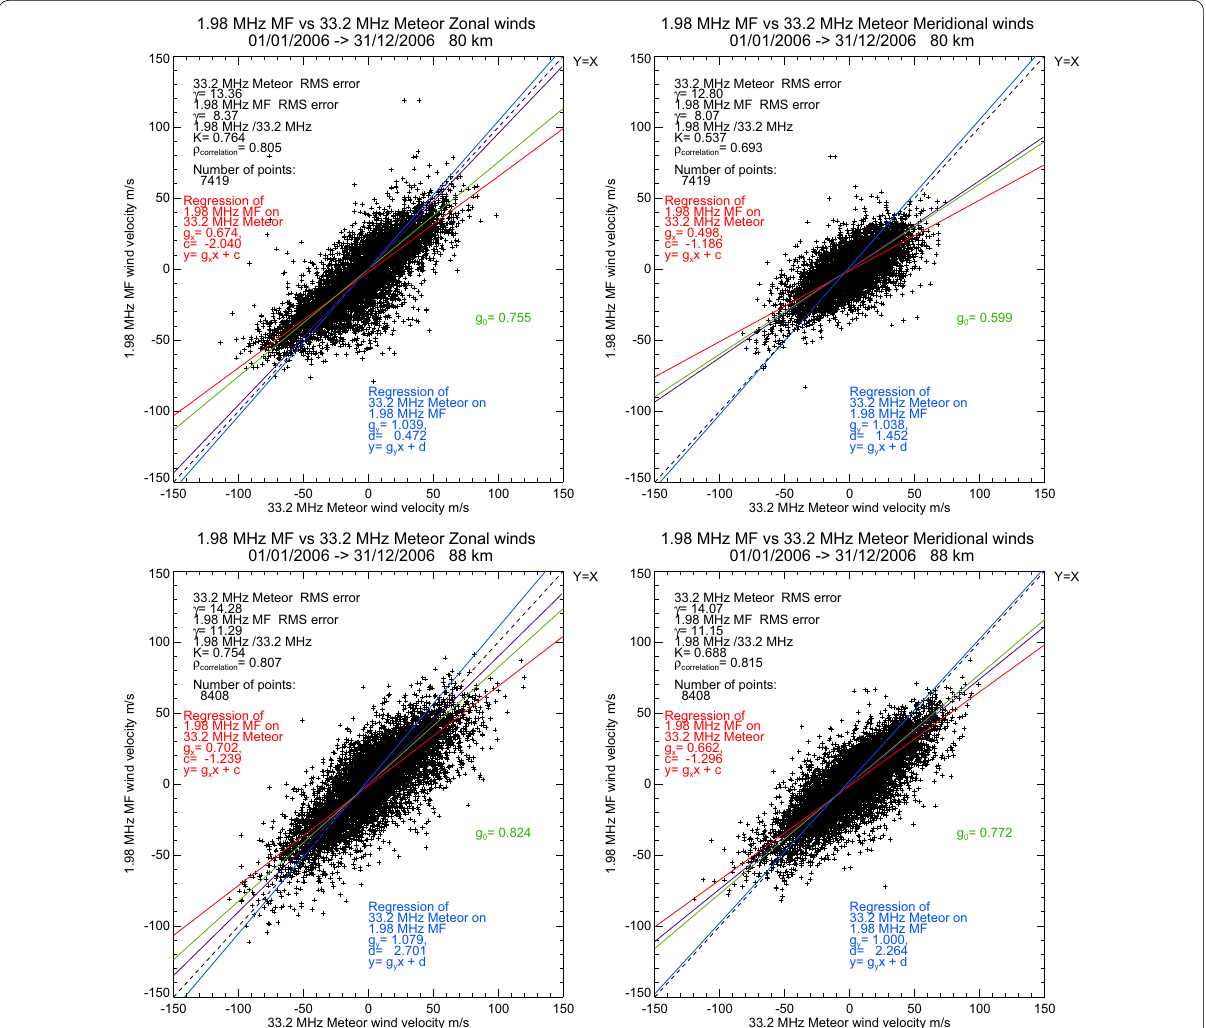
Fig. 5 Davis MF O-mode and 33.2 MHz meteor scatter plot. The purple line represents the slope derived using the error values from the meteor– meteor comparison when equal error between both meteor radar measurements was